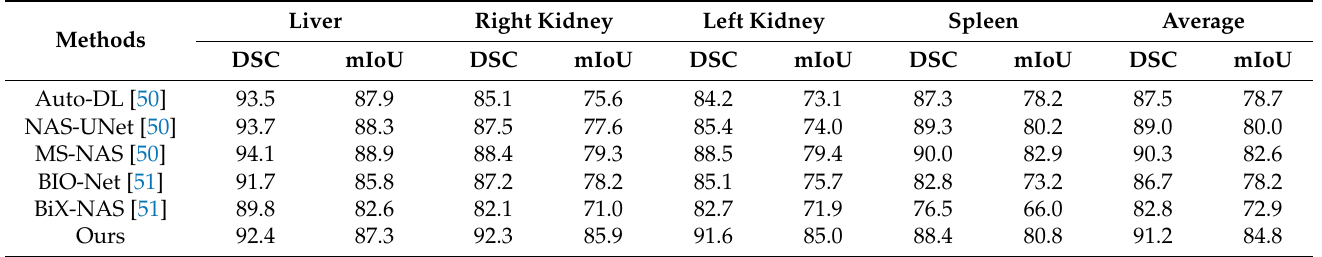
Table 4. Quantitative evaluation of different networks for the CHAOS(MRI) dataset in terms of DSC (%) and mIoU (%).